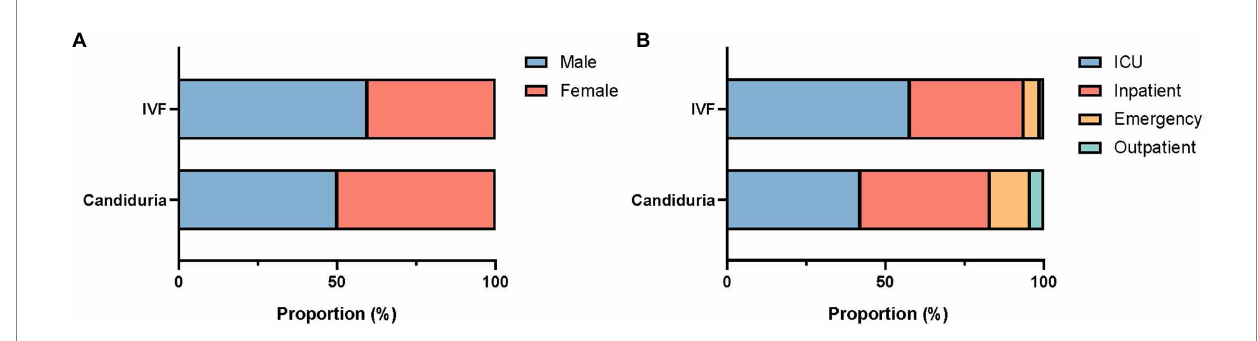
FIGURE 1 Gender (A) and patient location (B) composition of patients with candiduria and invasive infections